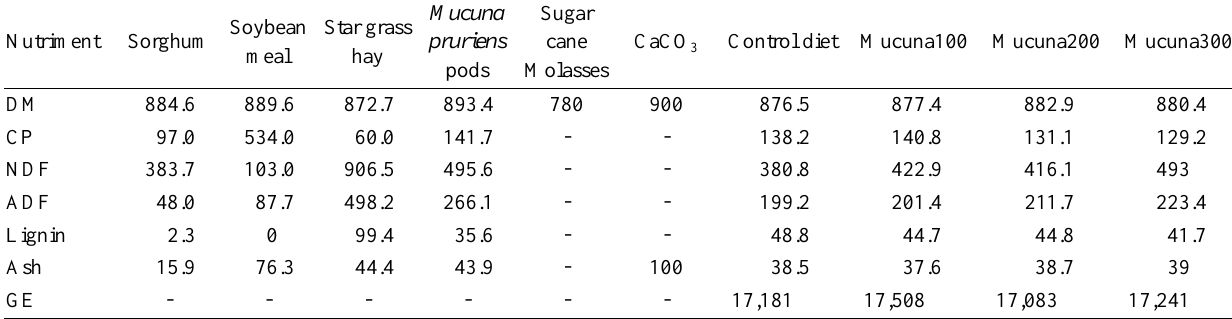
Table 1. Chemical composition of dietary ingredients and experimental diets and M. pruriens pods (g/kg DM) a